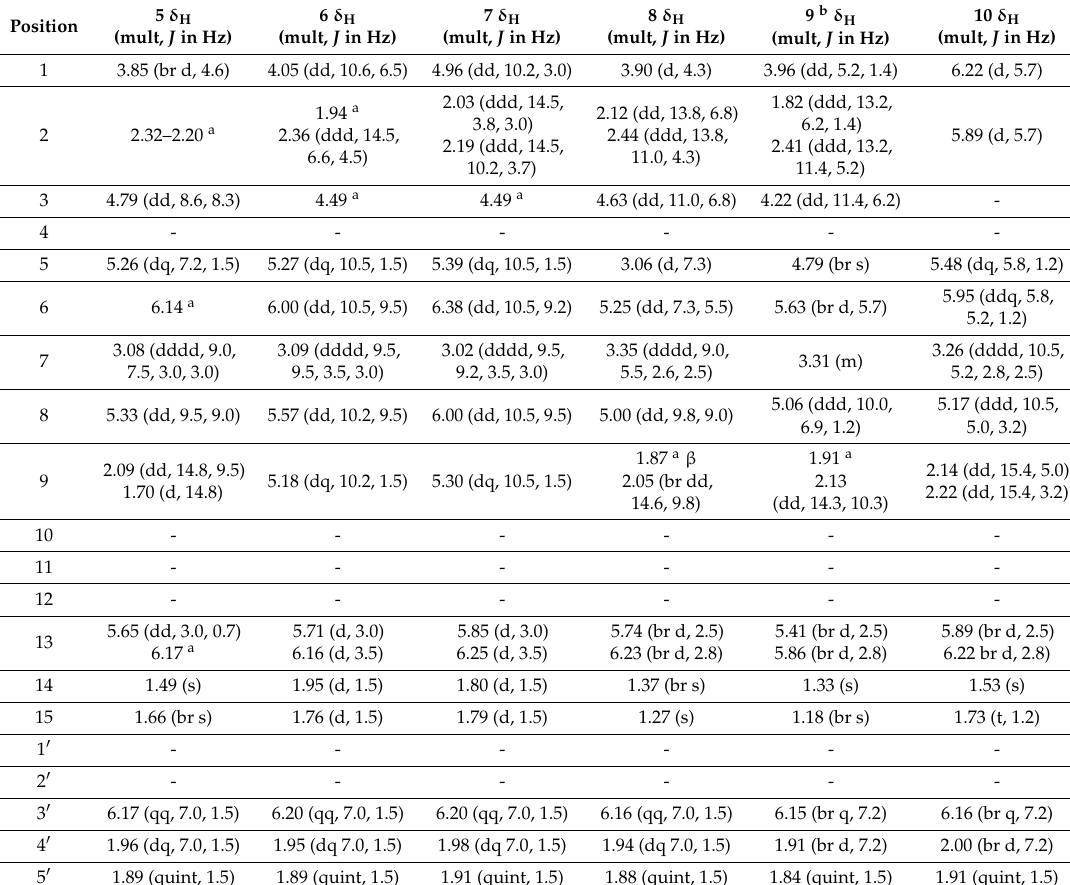
Scheme 3. Reactivity of 4 with acids. Table 1. 1 H-NMR spectroscopic data for compounds 5 – 10 (CD 3 OD for 5 – 9 , CDCl 3 for 10; 500.13 MHz; δ in ppm).